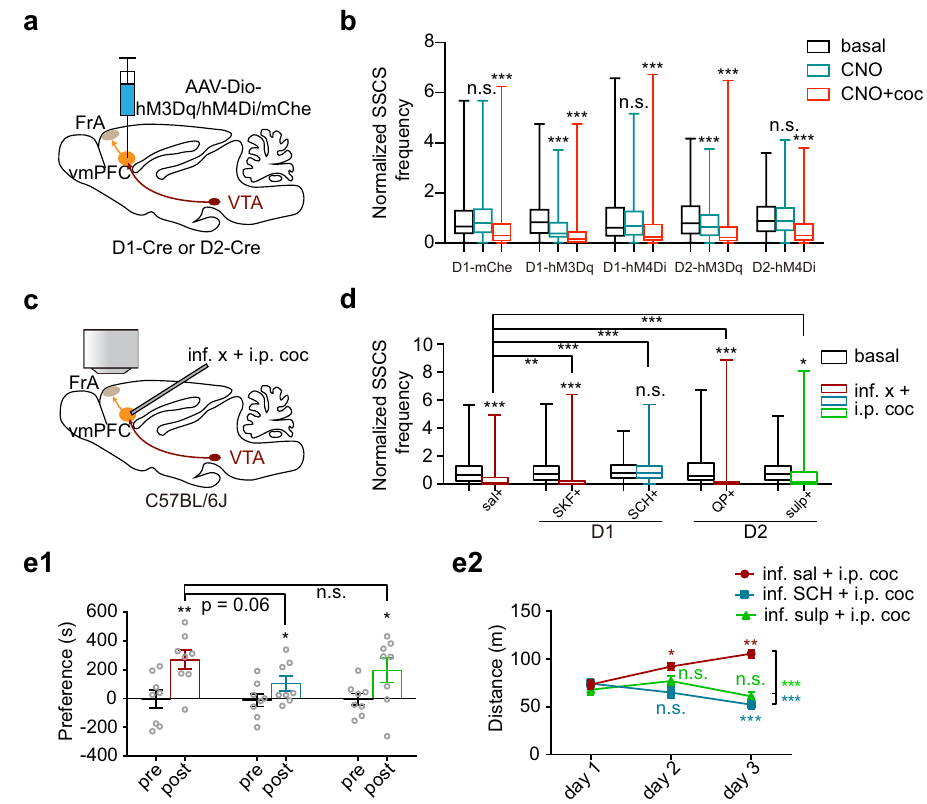
Fig. 6 | vmPFC modulates FrA and locomotor sensitization through dopamine D1 and D2 receptors. a , b Schematic of two-photon Ca 2+ imaging and statistics (minimum,maximum,andthreequartiles)ofnormalizedSSCSfrequencyintheFrA withvirusinjection(AAV-Dio-hM3Dq/hM4Di/mCherry)intothevmPFCofD1-Creor D2-Cre mice. Cocaine (i.p.) was injected 30min after CNO (i.p.) injection. Data for CNO were recorded 20 – 30min after injection and cocaine were 10 – 20min. D1- mChe, n =225 neurons from three mice; D1-hM3Dq, n =296 neurons from four mice;D1-hM4Di, n =333neuronsfromfourmice;D2-hM3Dq, n =245neuronsfrom three mice; D2-hM4Di, n =255 neurons from three mice, two-tailed Wilcoxon test. c , d Schematicoftwo-photonCa 2+ imagingandstatistics(minimum,maximum,and threequartiles)ofnormalizedSSCSfrequencyintheFrAfollowingmicroinfusionof a D1R agonist (SKF-38393, SKF) or antagonist (SCH-23390, SCH) or a D2R agonist (quinpirole, QP) or antagonist (sulpiride, sulp) into the vmPFC following i.p. cocaine in awake mice. Sal, n =191 neurons from four mice; SKF, n =212 neurons